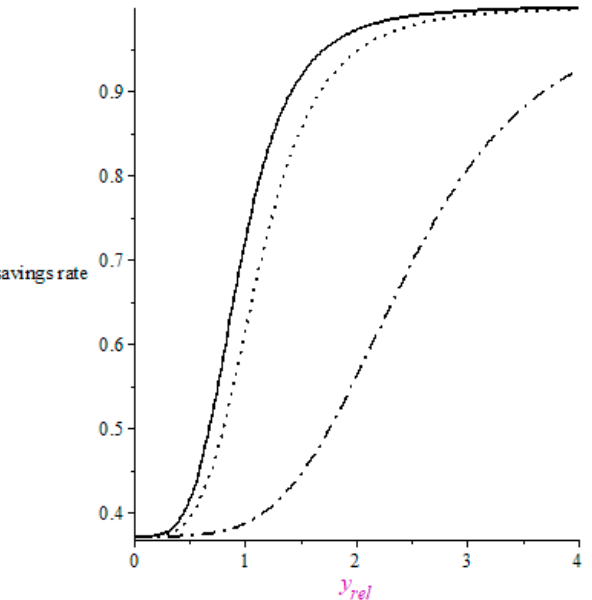
Figure 1. The savings rate depending on the relative income. The savings rates differ regarding the value of B : solid line B = 2, dotted line B = 1, dash-dot line B = 0.04. The solid line represents the savings rate with B = 2, the dotted line represents the savings rate with B = 1 and the dash–dot line the case if B = 0.04. The shape of the savings rate has a crucial influence on the relationship between the degree of competition and the growth of the economy represented by the growth factor G . However, the values